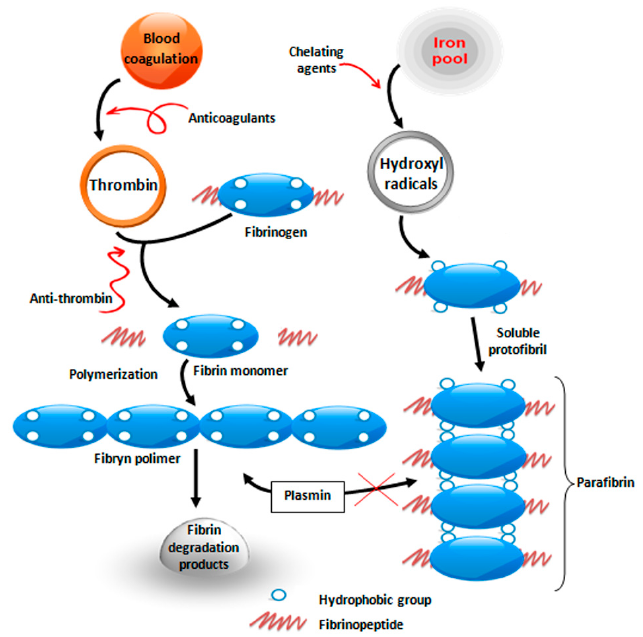
Figure 1. Schematic representation of thrombin-induced blood coagulation (left part) and the conversion of fibrinogen to insoluble polymer under the influence of iron (right part) based on references [7,8].